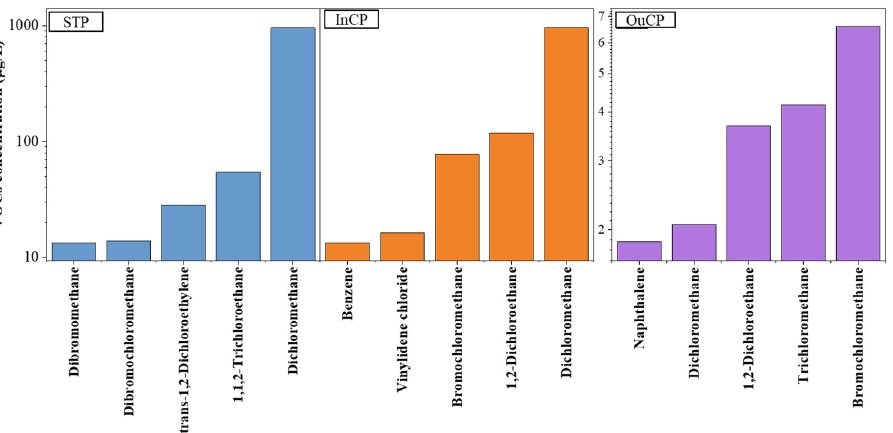
Figure 3. The top five VOC species in water samples collected at the sewage treatment plant (STP), inside the park (InCP), and outside the park